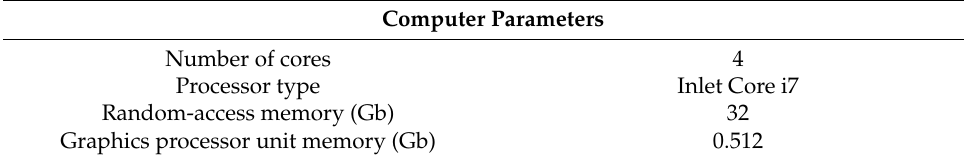
Table 4. The parameters of the